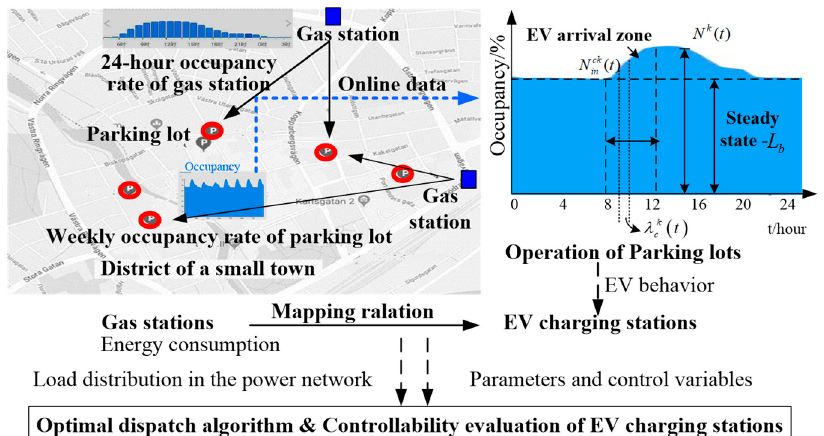
Figure 1. Modeling of the electric vehicle (EV) charging facilities changed from gas stations based on online data analysis.